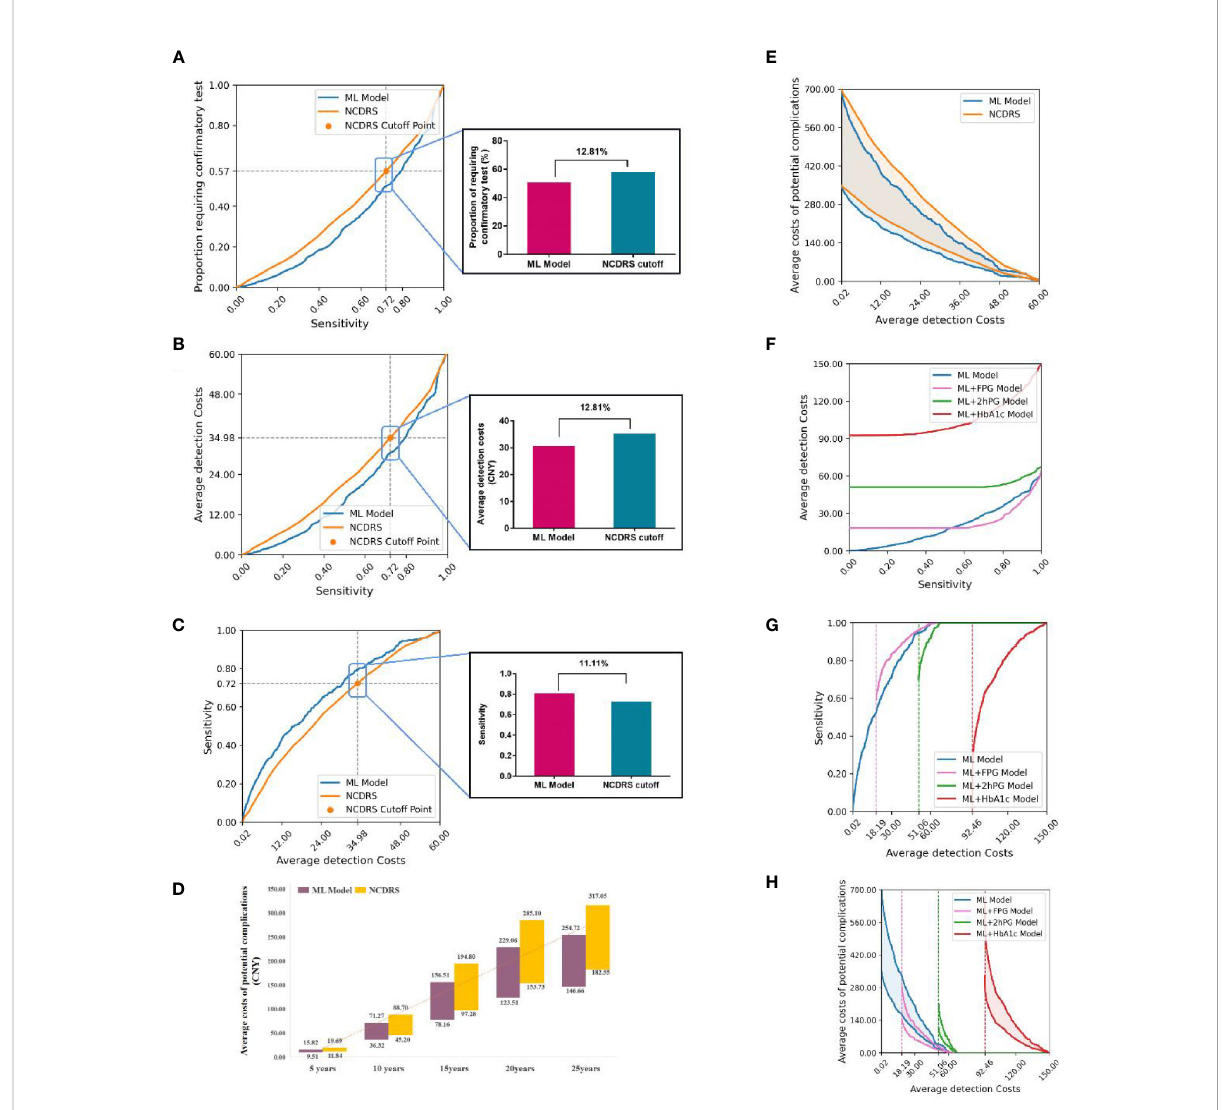
FIGURE 5 Comparison the health economic costs between ML and ML+lab models with their corresponding counterparts. (A-B) , Compared the proportion requiring con fi rmatory test (A) and average detection costs (B) between the ML model and NCDRS at a different level of sensitivity. (C) , Compared the sensitivity between the ML model and NCDRS at a different level of average detection costs. (D) , Compared the average costs of potential complications in the next 5-25 years between the ML model and NCDRS when the average detection costs was ¥34·98 (When using the cutoff point of the CDS guideline, the average detection costs of NCDRS were ¥34·98). (E) , Compared the average costs of potential complications between the ML model and NCDRS at a different level of average detection costs. (F) , Compared the average detection costs at a different level of sensitivity between the ML model with ML+lab models. g-h, Compared the sensitivity (G) and the average costs of potential complications for 15 years (H) at a different level of average detection costs between the ML model with ML+lab models. The number on the horizontal line (A-C) represents the relative reduction of the proportion requiring con fi rmatory test, average detection costs, and increase of sensitivity of the ML model compared to the NCDRS. The numbers in the bar chart (D) represent the range of average costs of potential complications. The dotted lines in (G, H) represent the basic average detection costs of the ML+lab models which are the costs of screening test of these models. Shaded areas represent the range of average costs of potential complications for 15